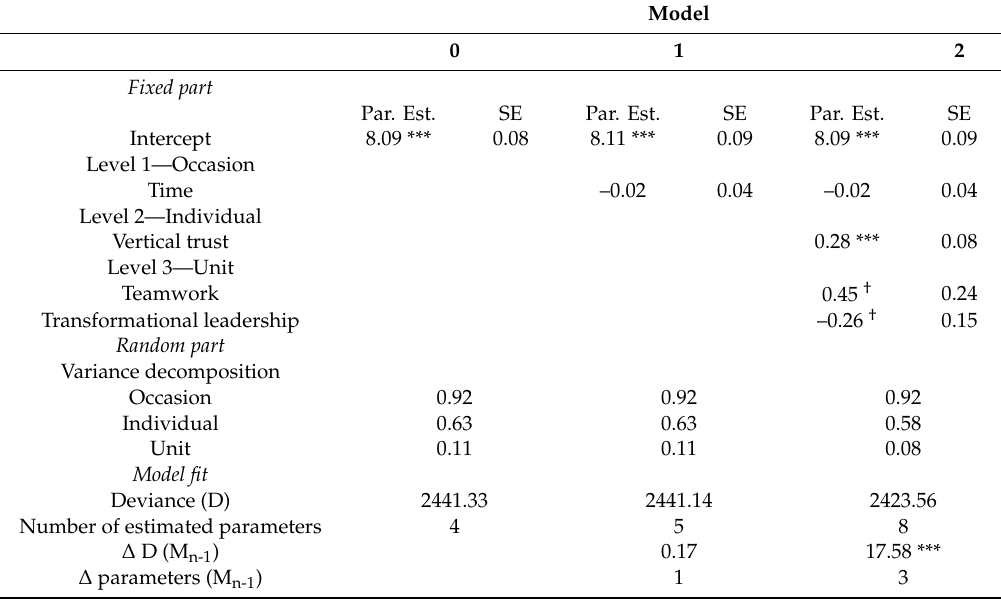
Table 6. Multilevel analysis predicting productivity from time (Level 1), trust (Level 2), and teamwork and transformational leadership (Level